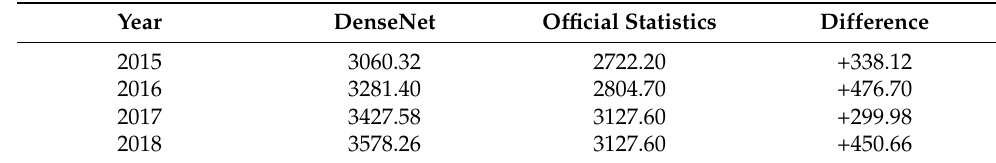
Table 4. Comparison of total cultivated cotton acreage from 2015–2018 based on DenseNet estimation and the official statistics (expressed in km 2